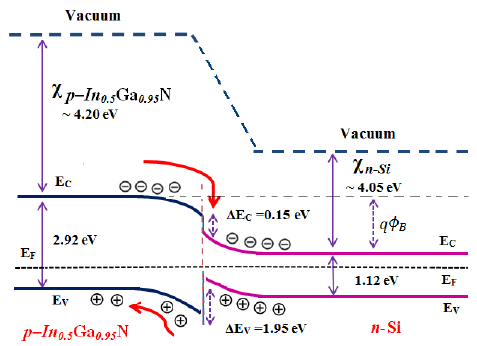
Figure 2. Energy band diagram of the p–In 0.5 Ga 0.95 N / n– Si hetero junction diode.